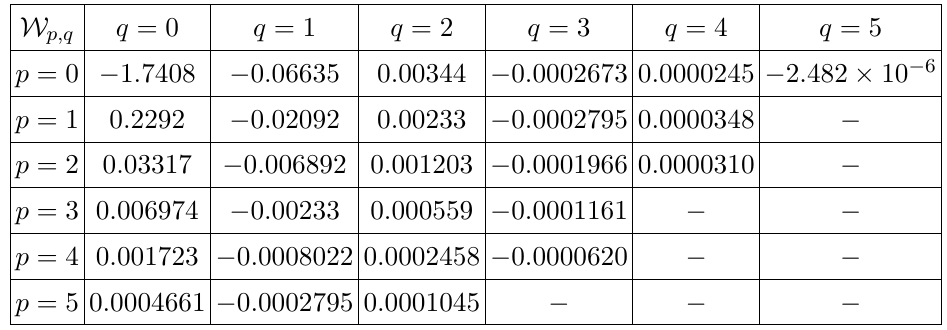
Table 5. The W p,q corresponding to the 1-loop φ 4 amplitude for charged scalars.